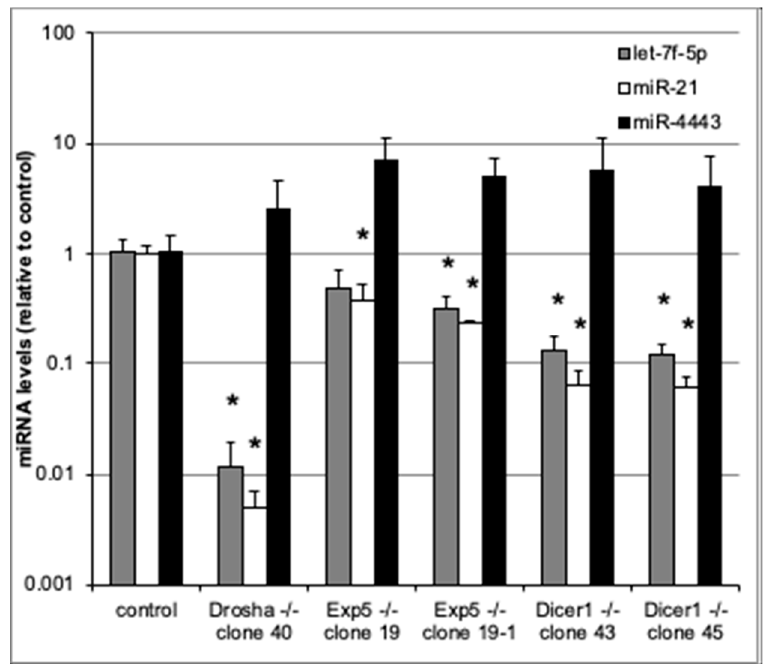
Figure 2. qRT-PCR for miR-4443, let7f-5p, and miR-21 in cultured HCT-116 cells with knockouts of Drosha, Exportin 5, or Dicer genes and controls. The levels of each microRNA relative to control are shown. Note logarithmic scale of vertical axis. Bars: st. dev. from biological triplicates. * p < 0.05 ( t test).